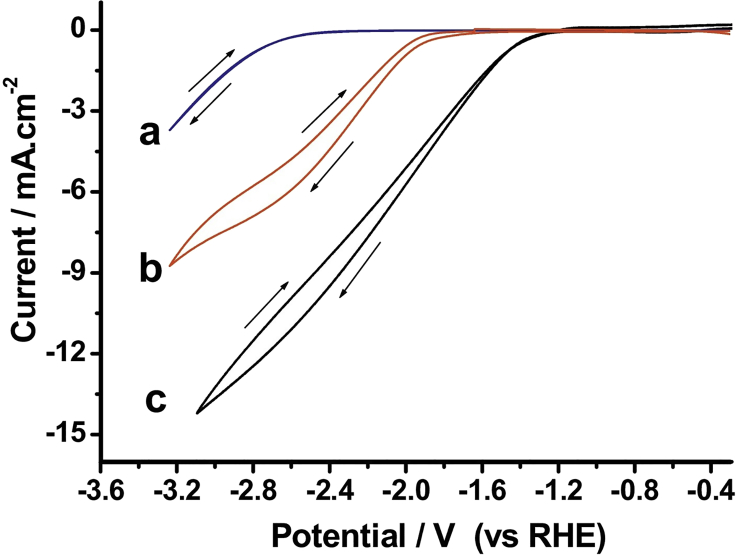
Cyclic Voltammograms at Au versus Reversible Hydrogen Electrode (RHE) in 0.1 M Bu4NClO4/PC, (a) Ar Saturated, (b) CO2 Saturated, and (c) CO2 Saturated, 6.8 wt. % H2O in ElectrolyteReproduced with permission from (Shi et al., 2017).